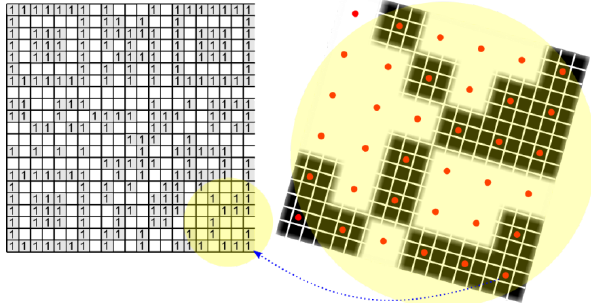
Figure 15. Transformation of the QR Code into the binary grid.